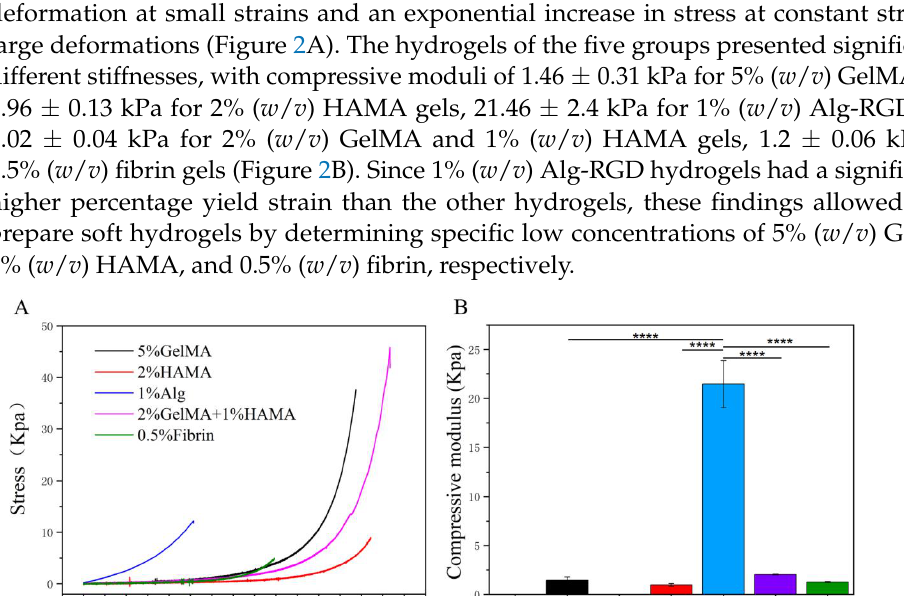
Figure 1. High purity and good differentiation of hESC-RPE. ( A ) hESCs (Q-CTS-hESC-2). ( B ) ESCs were perfused after pigment granule deposition. ( C ) Isolation of pigment foci as the beginning of differentiation of hESC-RPE cells. ( D ) RPEs showed the typical cobblestone-like morphology, as well as pigment accumulation. ( E ) Second generation hESC-RPE. ( F ) Third generation hESC-RPE. ( G ) Immunostaining of bestrophin-1, CRALBP, MITF, PAX6 in hESC-RPE cells (third generation).